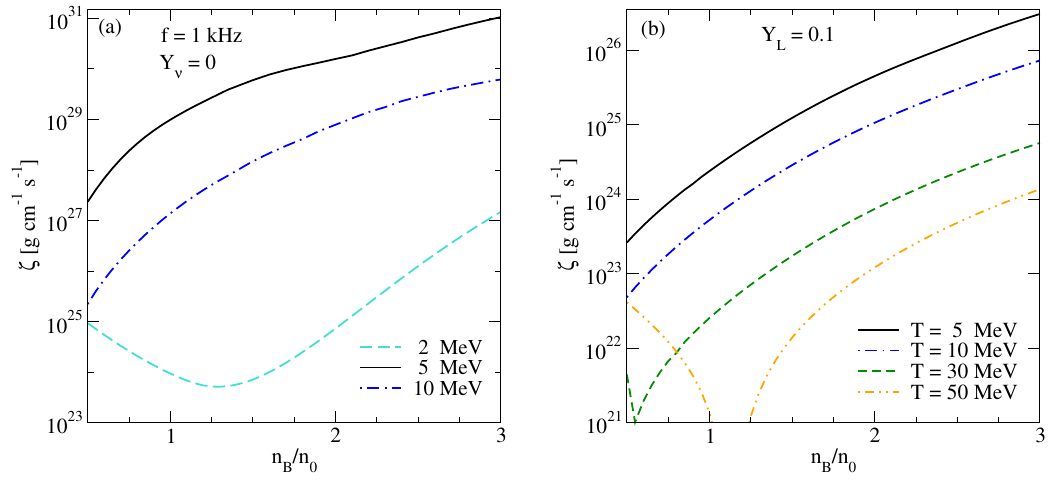
Figure 4. The density dependence of the bulk viscosity for ( a ) neutrino-transparent matter; ( b ) neutrino-trapped matter at Y L = 0.1 for various values of the temperature. The oscillation frequency is f = 1 kHz in panel ( a ); the bulk viscosity in panel ( b ) is frequency independent. Note the very different y -axis